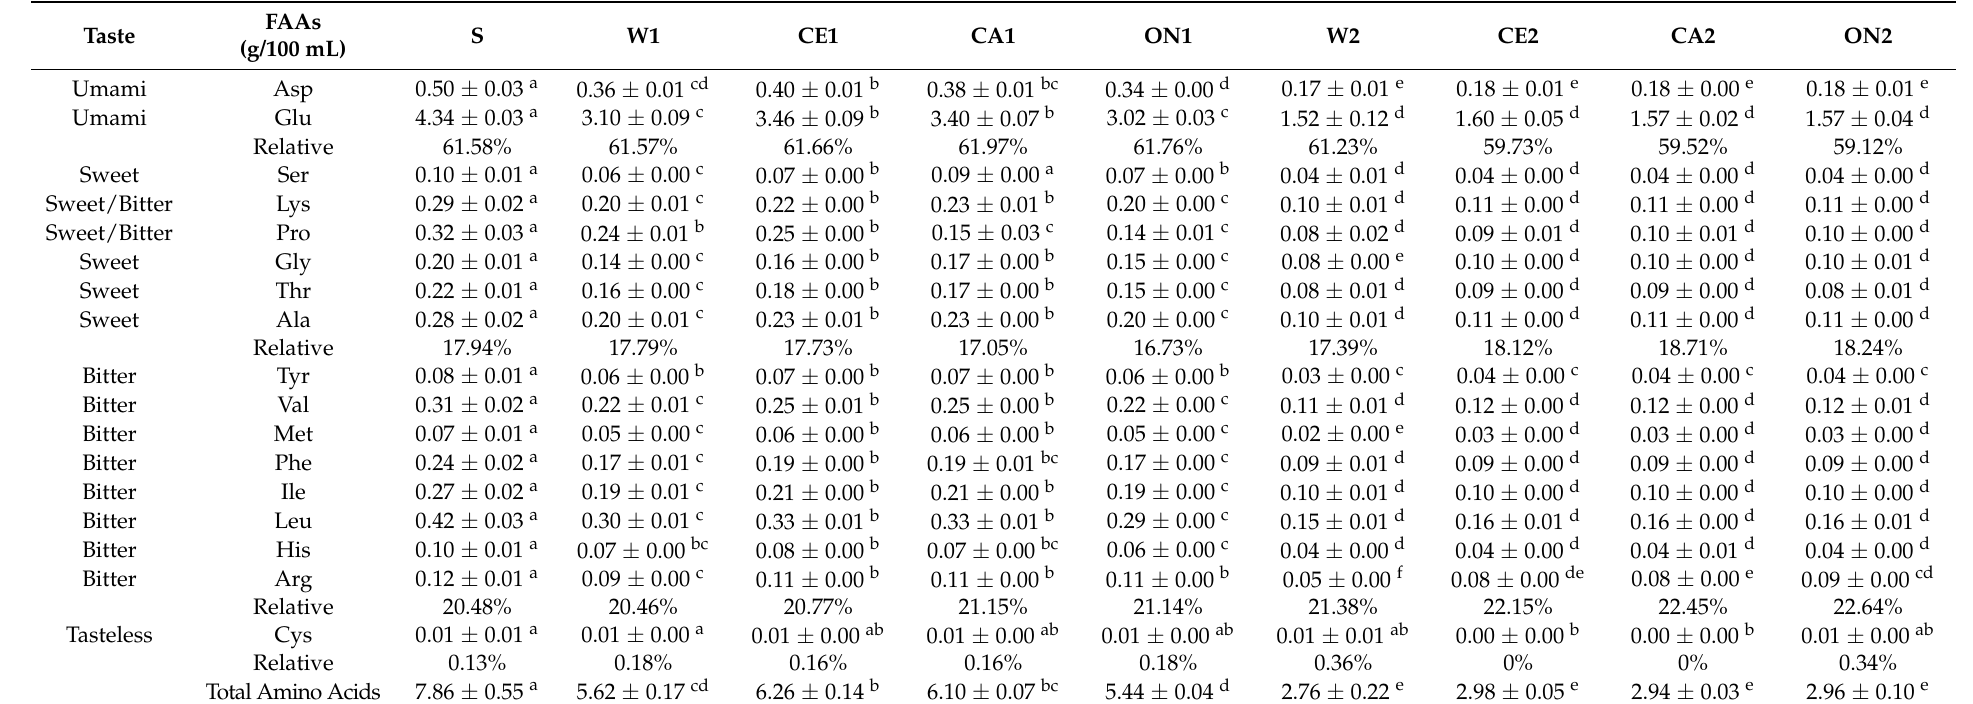
Table 4. Free amino acid content of soy sauce with different